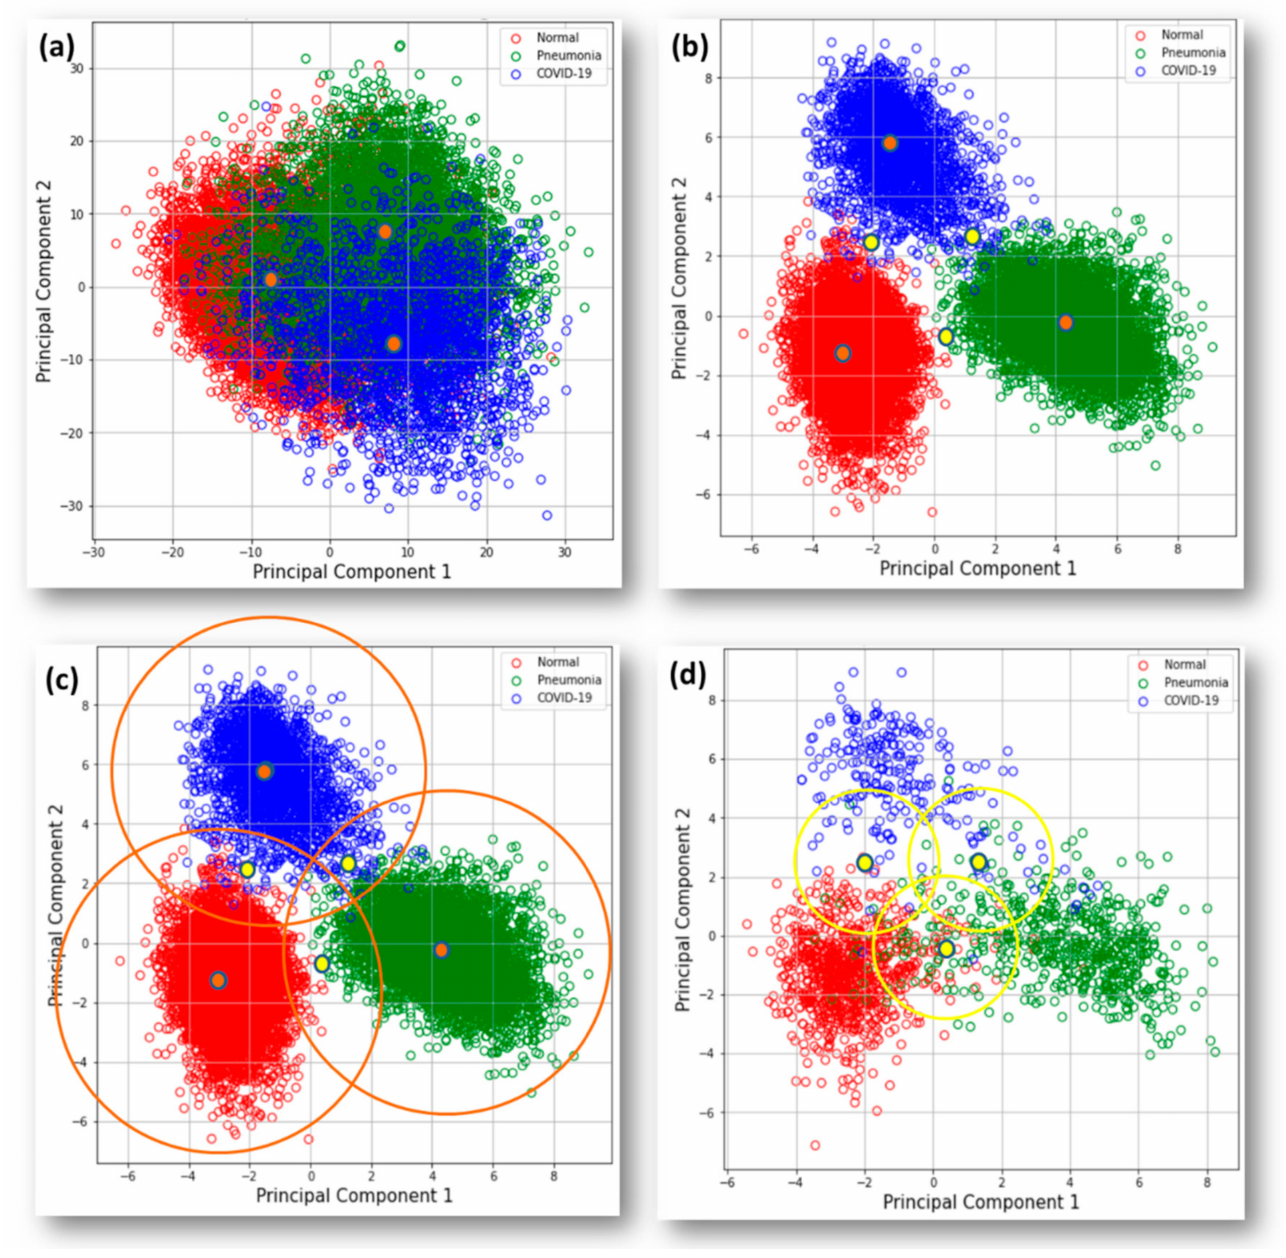
Figure 6. PCA visualization of the training set clusters in two-component: ( a ) Down-sampling distribution based on extracted 1000 vectors with MobilNetV1 pre-trained by Imagenet. ( b ) Status based on trained MobileNetV1 feature extraction block. It also shows cluster centers in orange and boundary centers in yellow. ( c ) Orange circles are the outlier boundaries specific to different categories. ( d ) Yellow circles are boundary sketches to separate both high and low-accuracy